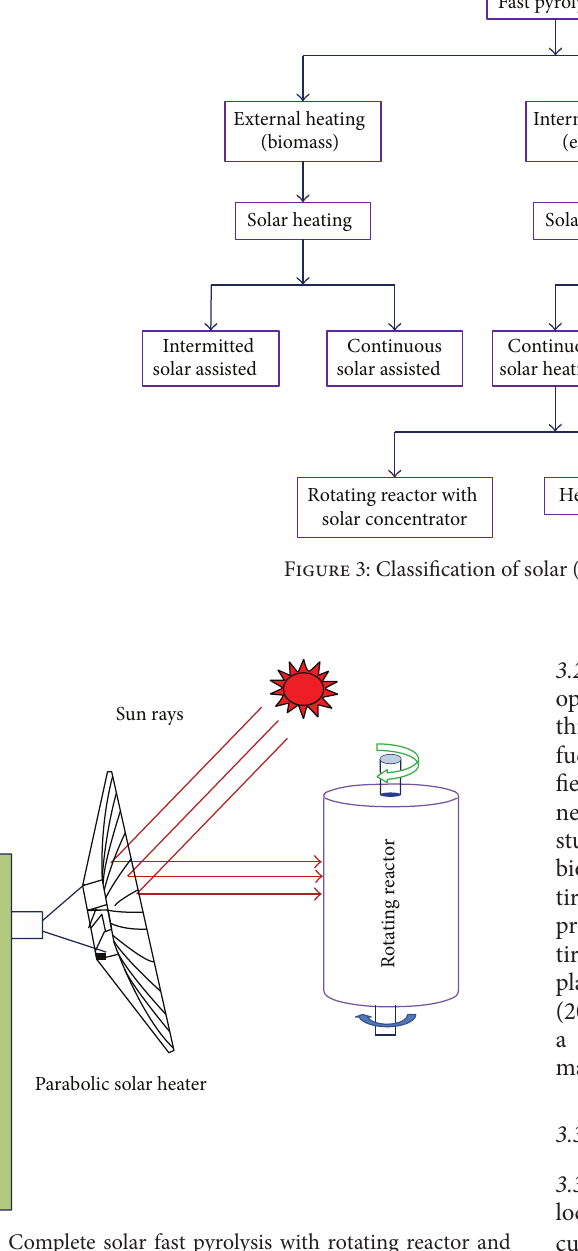
Figure 4: Complete solar fast pyrolysis with rotating reactor and sliding solar concentrator